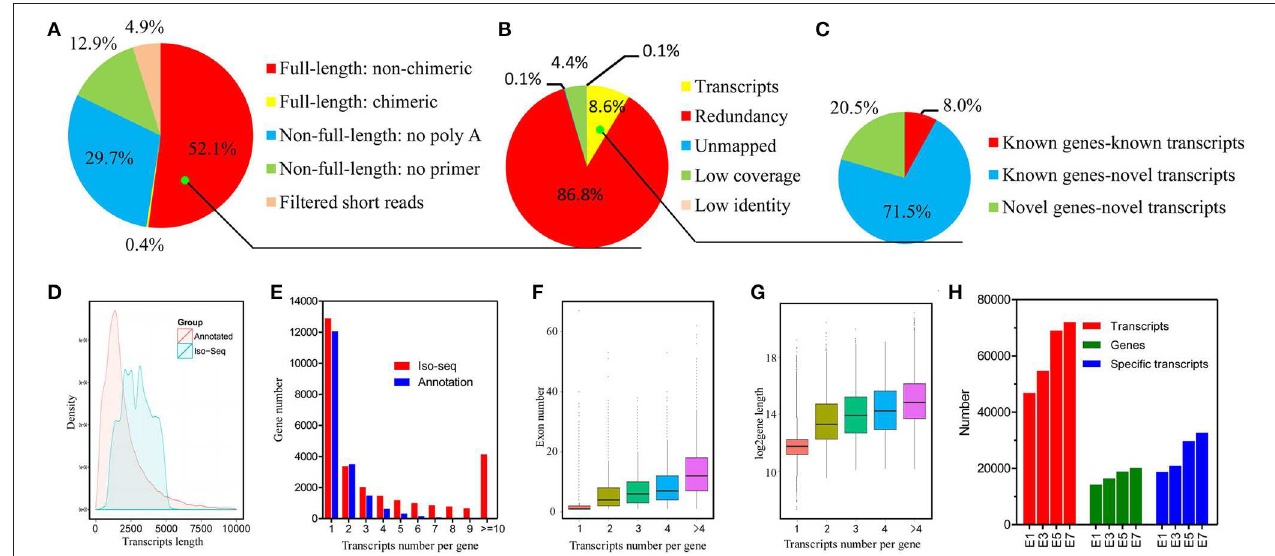
FIGURE 1 | Identification and characterization of chicken embryo transcripts. (A) Raw Iso-Seq reads were divided into five groups to filter FLNC reads. (B) FLNC reads were divided into five groups based on their genome mapping characteristics to filter transcripts. (C) All transcripts were divided into three groups based on their genome annotations. (D) Density plot of the length of the PacBio transcripts and previously annotated transcripts. (E) Distribution of the number of transcripts per gene generated by PacBio data and reference genome data. (F) Comparison of exon numbers among genes producing different numbers of transcripts. (G) Comparison of gene length among genes producing different numbers of transcripts. (H) Identified genes and transcripts in embryos at different developmental stages by